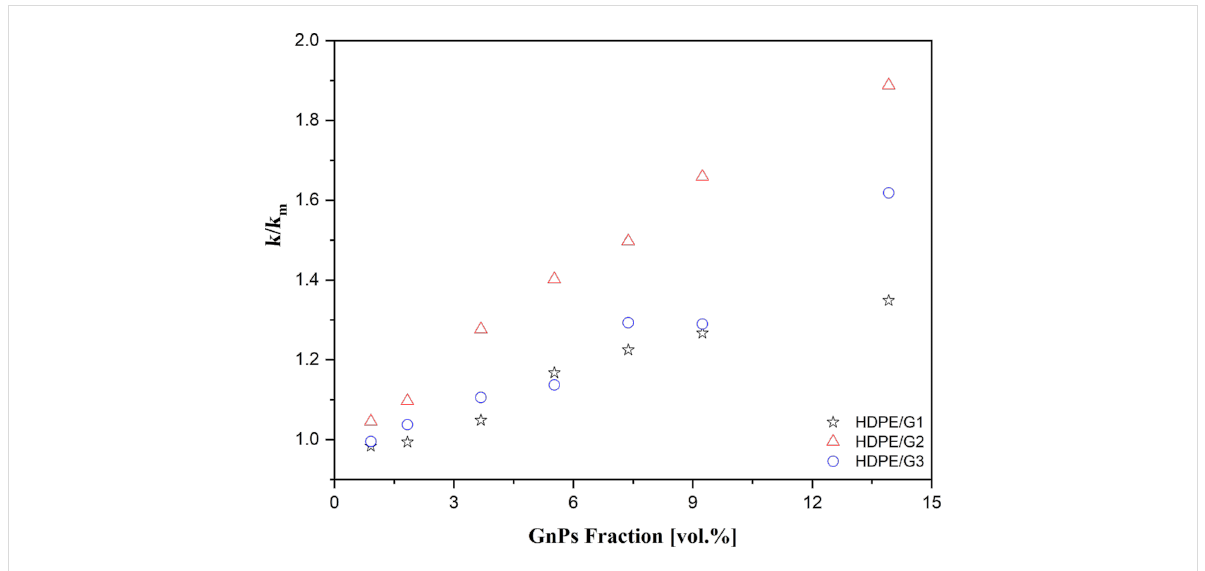
Figure 5: The relative thermal conductivity values of HDPE-based nanocomposites with G1, G2, and G3 fillers ( k m was equal to the thermal conduc- tivity of the matrix).